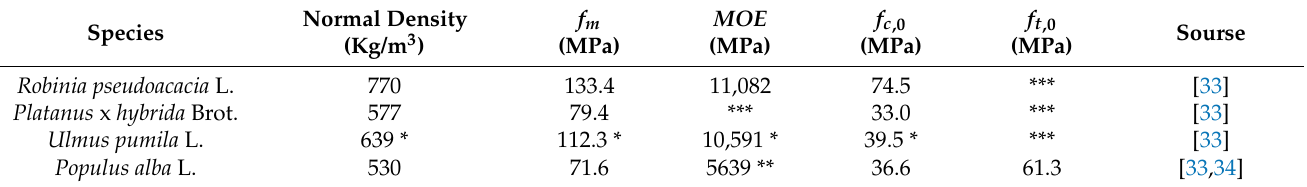
Table 5. Reported values for normal density, bending strength, modulus of elasticity, compression, and tension parallel to grain. Normal Density Species